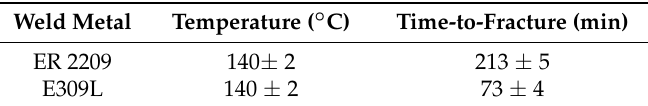
Table 3. SCC tests’ results.